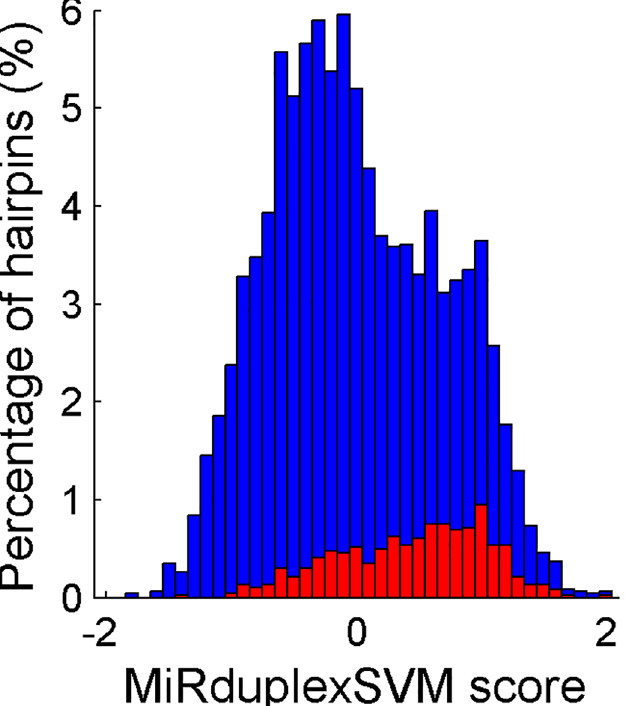
Fig 5. Identification of high confidence miRNAs. As shown in the figure MiRduplexSVM assigned a higher score to 554 high confidence miRNAs (blue bars, median = 0.53 and mean = 0.44) than to 554 randomly selected miRNAS (red bars, median = -0.24 and mean = -0.14) with the observed differences being statistically significant (ranksum: p = 8.3084e-47 and t-test: p = 3.9577e-50). The x axis shows MiRduplexSVM ’ s scores and the y axis shows the percentage of hairpins assigned with the respective